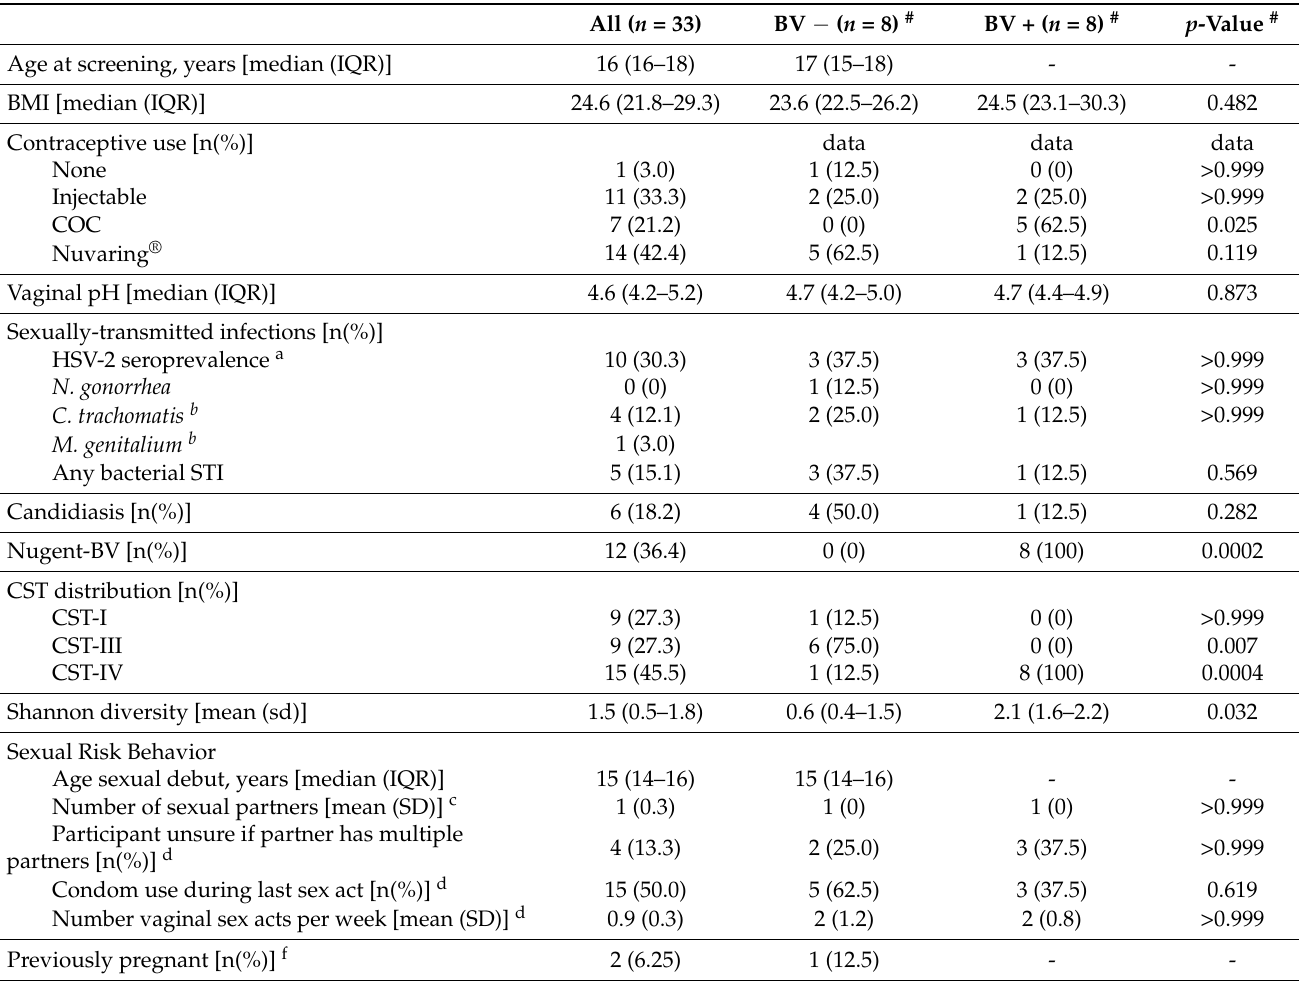
Table 1. Characteristics of participants included in the viral metagenome